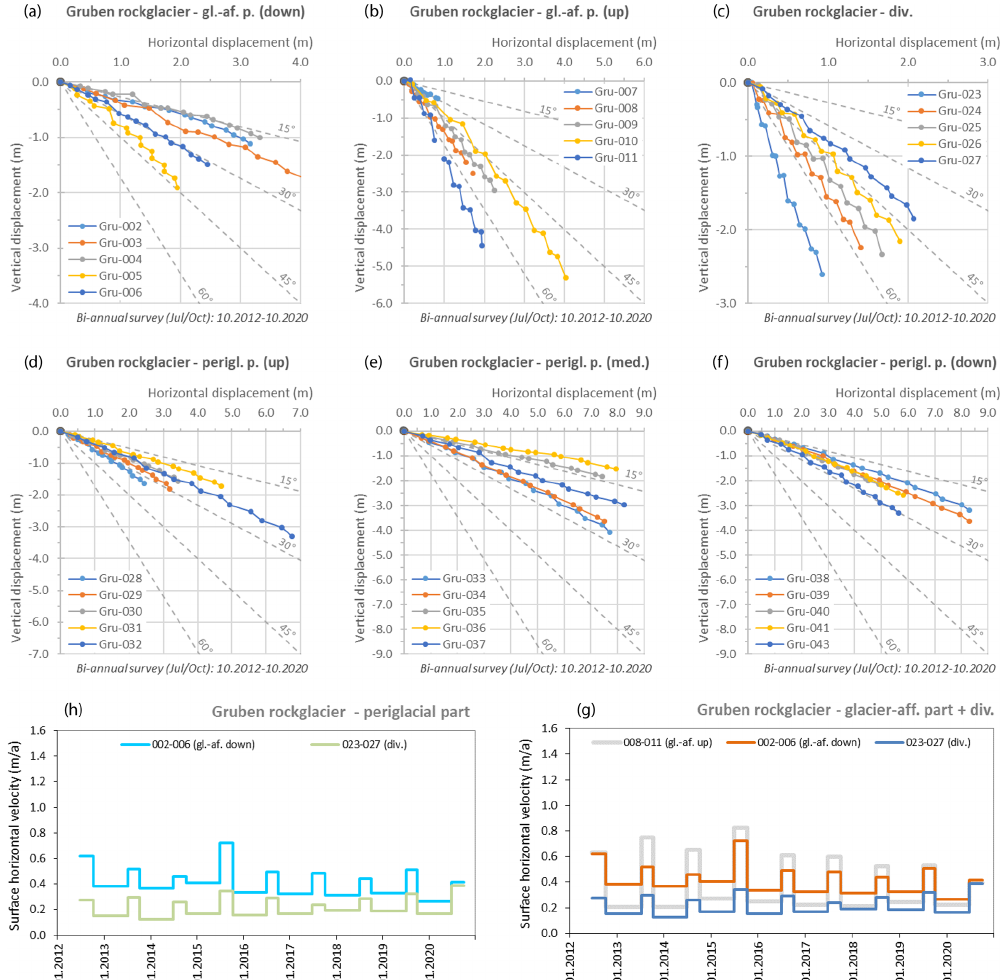
Figure 7. GNSS-based kinematic behaviour in both glacier-affected (gl.-af.) and periglacial (perigl.) parts of the Gruben rock glacier as well as in their transition zone (div.). (a–f) Horizontal versus vertical displacement of selected items. (g–h) Seasonal horizontal velocities in specific sections. The numbers or identifiers refer to the GNSS-surveyed items; location in Fig.